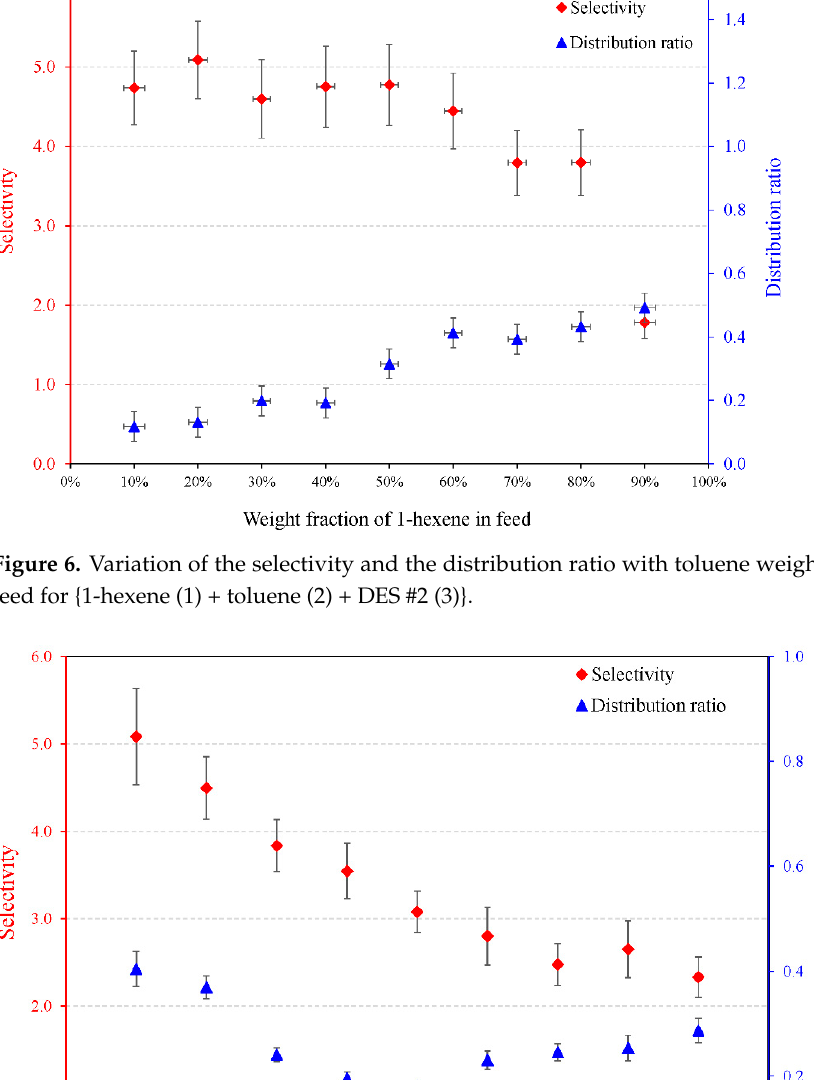
Figure 5. Variation of the selectivity and the distribution ratio with toluene weight fraction in the feed for {1-hexene (1) + toluene (2) + DES #1 (3)}.